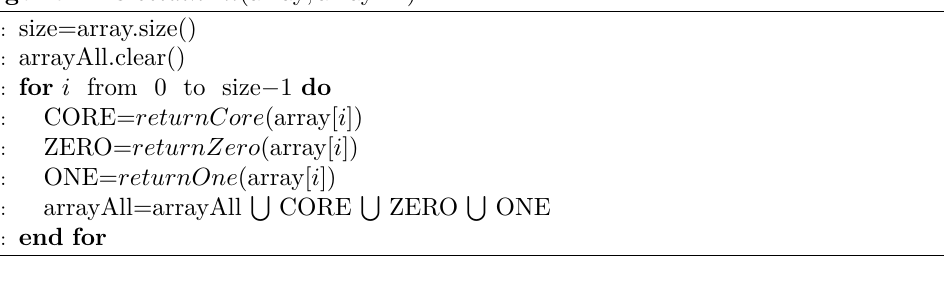
Algorithm 3 obtainAll (array ,